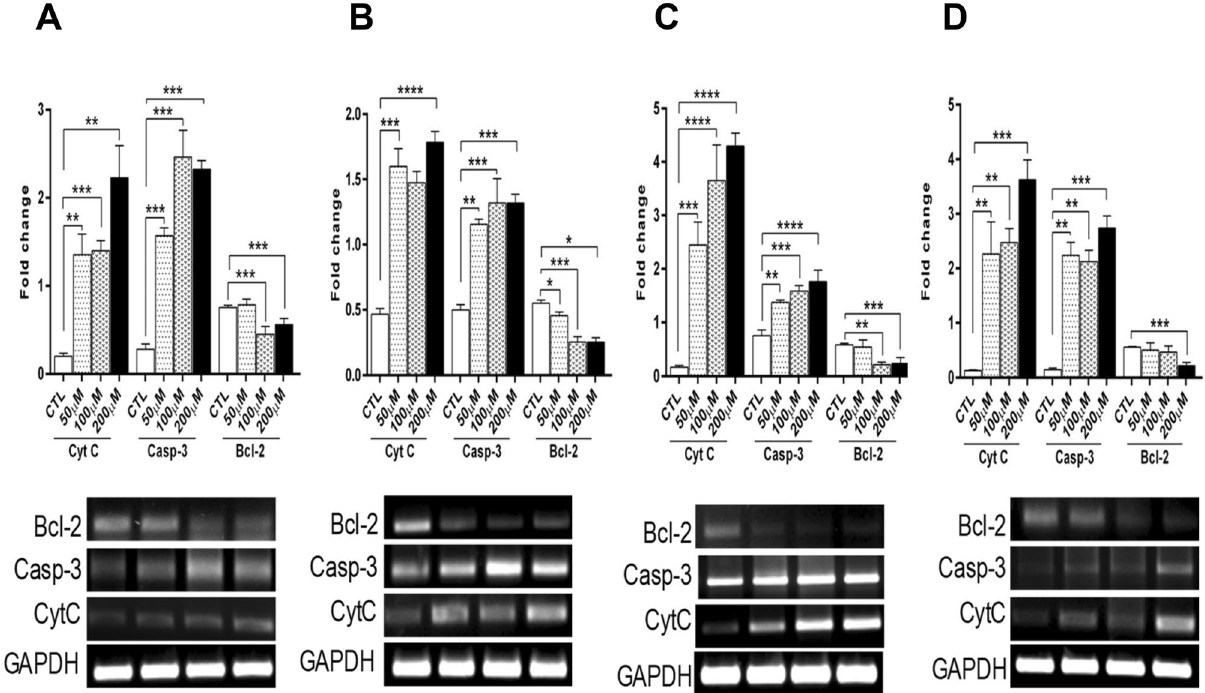
Figure 4. Apoptotic and anti-apoptotic gene expression levels in DKPs treated and un-treated HT-29 cells for 24 h. DKP-1: cyclo (l-Pro-l-Leu) ( A ), DKP-2: cyclo (l-Pro-l-Val) ( B ), DKP-3: cyclo (l-Pro-l-Phe) ( C ), and DKP-4: cyclo (l-Pro-l-Tyr) ( D ). The sqRT-PCR analysis was performed in triplicates, and each bar represents the mean ± SD (n = 3). Data were analyzed by one-way ANOVA with student’s two-tailed t -test. The asterisks * p < 0.05, ** p < 0.001, *** p < 0.0001, **** p < 0.0001, indicates a significant difference between the untreated cells in response to DKPs treated cells. The groupings were cropped from different gels subjected to identical conditions. Full gel images were shown in the Supplementary Information, Fig.